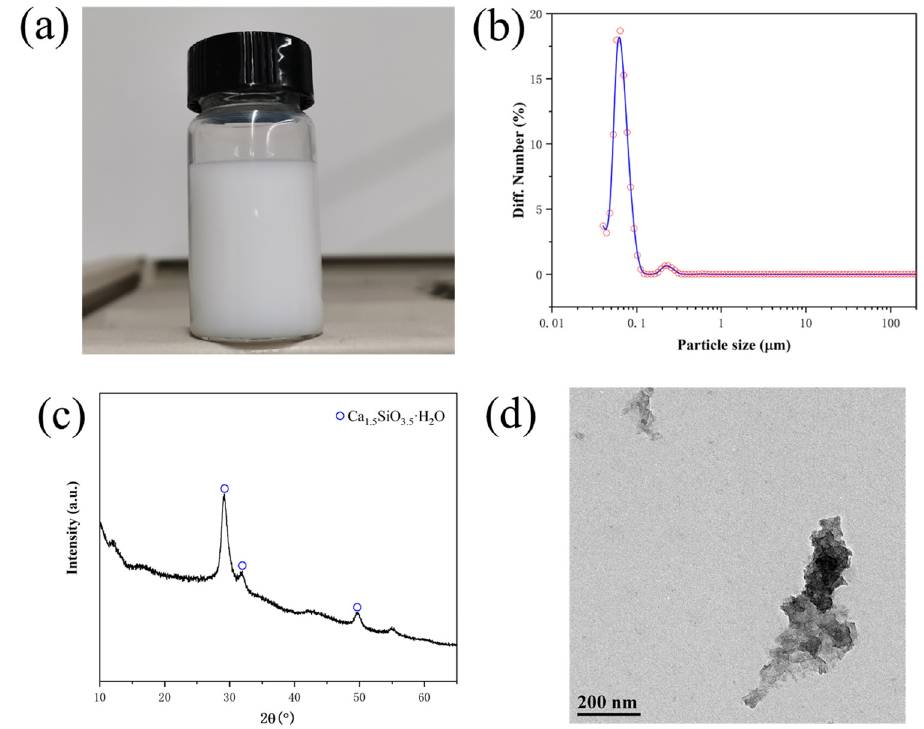
Figure 1: ( a ) Digital image of nano C – S – H; ( b ) particle size distribution curve of nano C – S – H; ( c ) X - ray di ff raction pattern of nano C – S – H; and ( d ) TEM image of nano C – S –